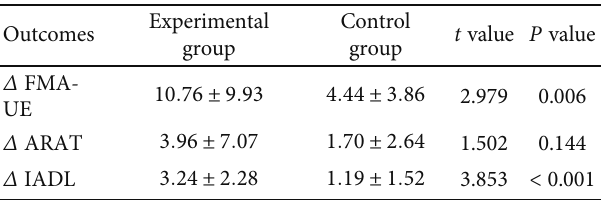
Table 3: The comparison of delta scores of measures between two groups after